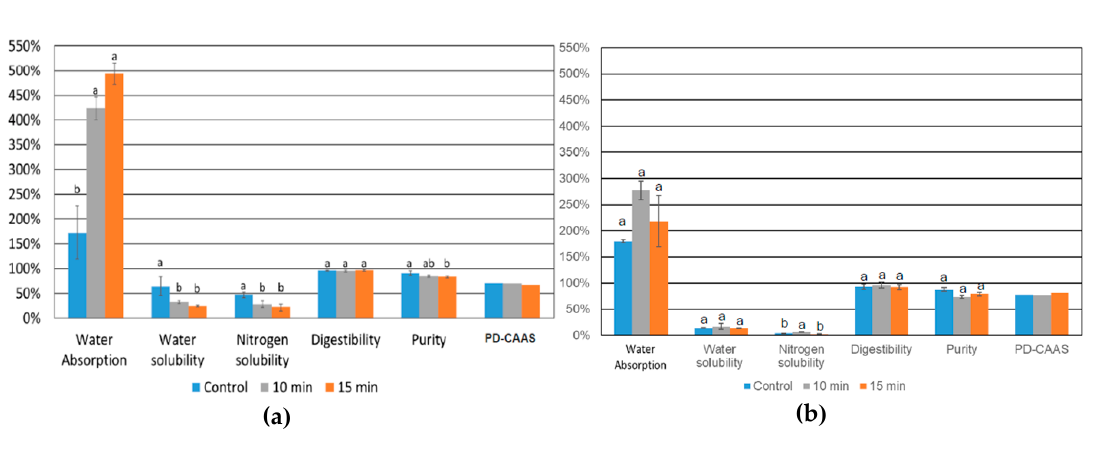
Figure 8. Functional properties of protein isolate from ( a ) L. mutabilis and ( b ) L. angustifolius obtained with alkaline process assisted with US. Bars with different letters within each functionality differ significantly ( p < 0.05).